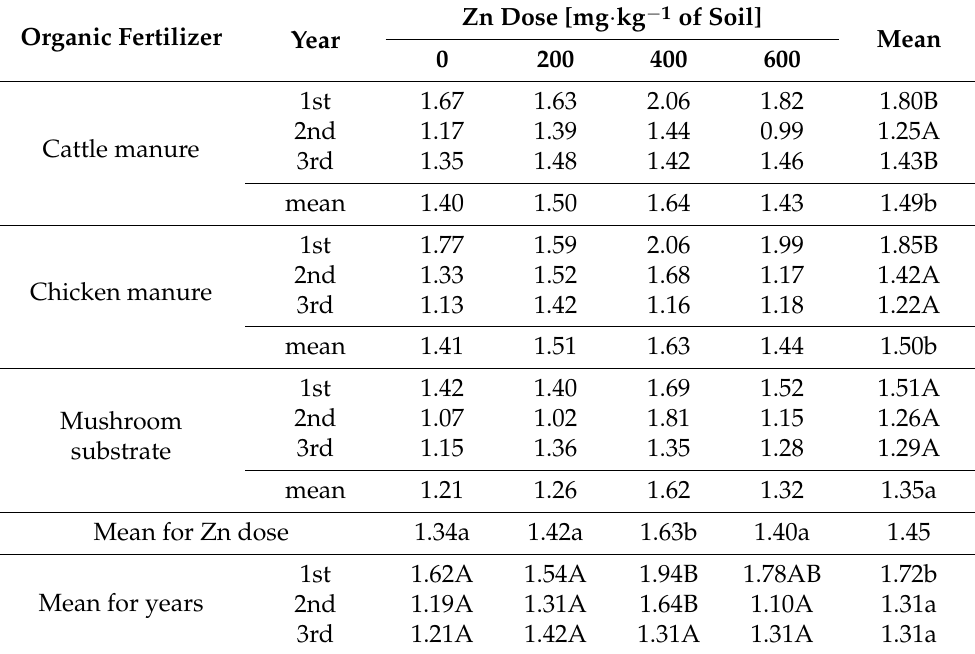
Table 4. Tolerance index illustrating the effect of various organic fertilizers in combination with increasing levels of zinc—Org/Zn.